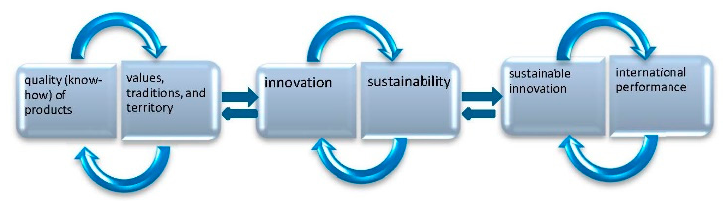
Figure 1. Quality-sustainability-international performance relationships.